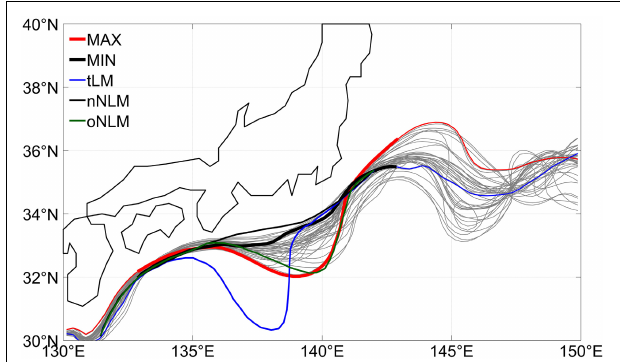
FIGURE 6 | Paths of the 100 cm SSH contour in the KSJ region. Gray curves are snapshots 8 months apart. Thick curves are the overall shortest and longest paths. The three well-known typical states of the KSJ, i.e., the tLM, nNLM, and oNLM states defined conventionally by Kawabe (1985) are shown with thin colorful